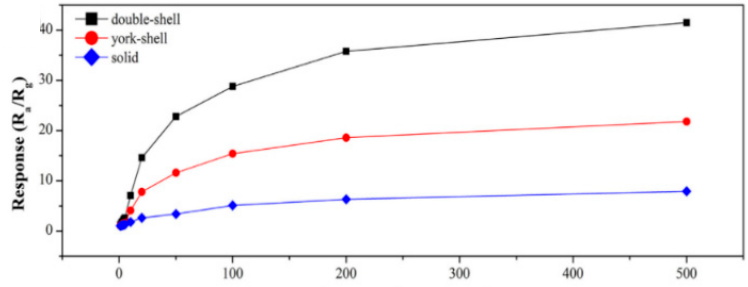
Figure 14. Response of ZnFe 2 O 4 double-shell, core-shell and solid microspheres sensor as a function of acetone concentration [59].